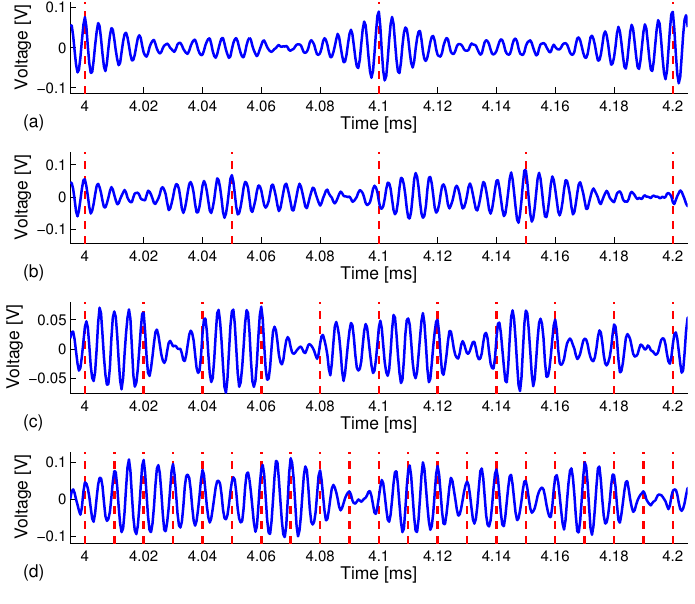
Figure 8. Snapshots of the received information carrying waveforms in the time window of 4 . 0 ms - 4 . 2 ms obtained from a stainless steel pipe (not filled with water). The data rates are ( a ) 10 kbps; ( b ) 20 kbps; ( c ) 50 kbps; and ( d ) 100 kbps.